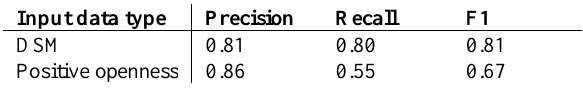
Table 1. Results from both visualisation types evaluated against the test tile ground truth locations